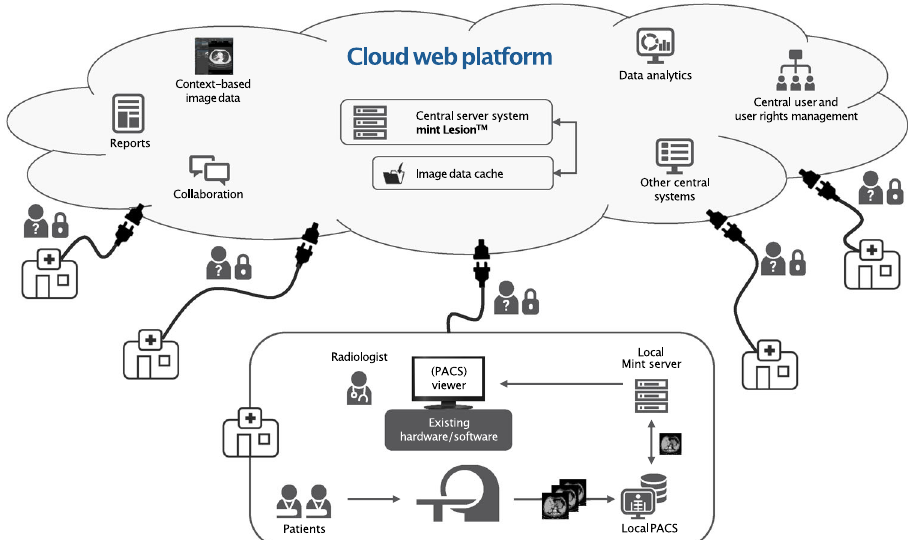
Fig. 2 System architecture of a cloud-based web platform. Every healthcare center can upload anonymized data to the web platform and use the Mint EDC based on the mint Lesion TM medical product software package, either by using a local instance or directly via the cloud- based web